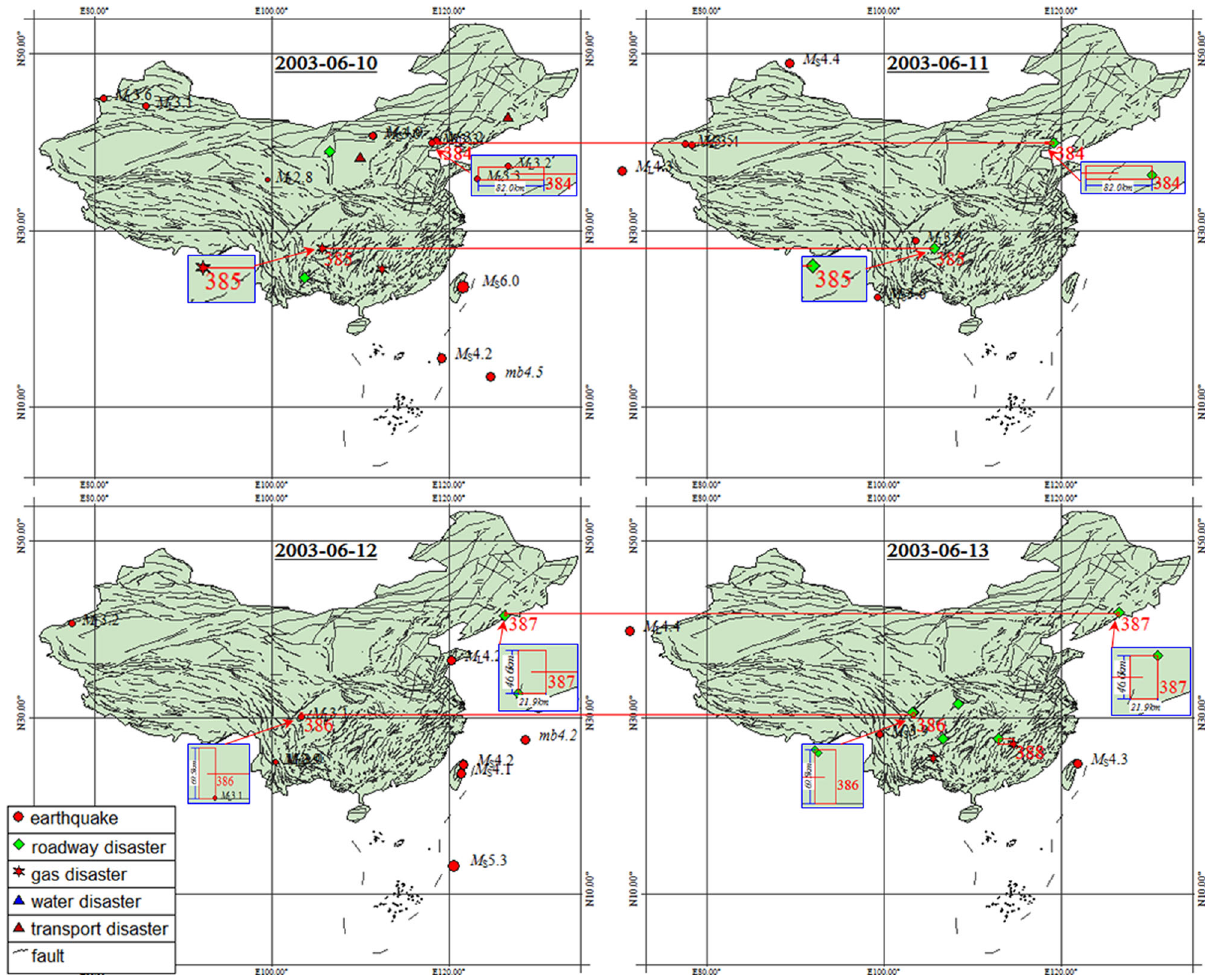
Fig. 5 Earthquakes and coal mine disasters occurring during the period from 10 to 13 June